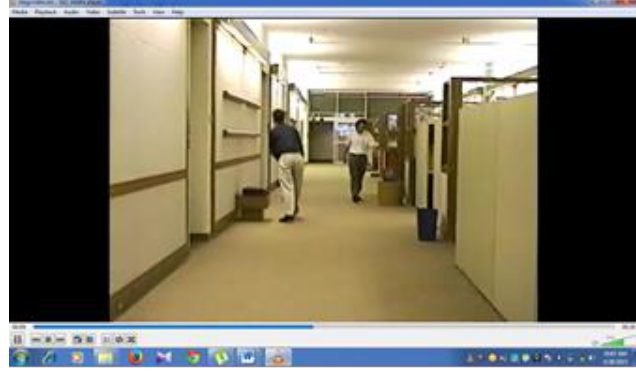
The text selected is embedded in the specified frame . is saved in a